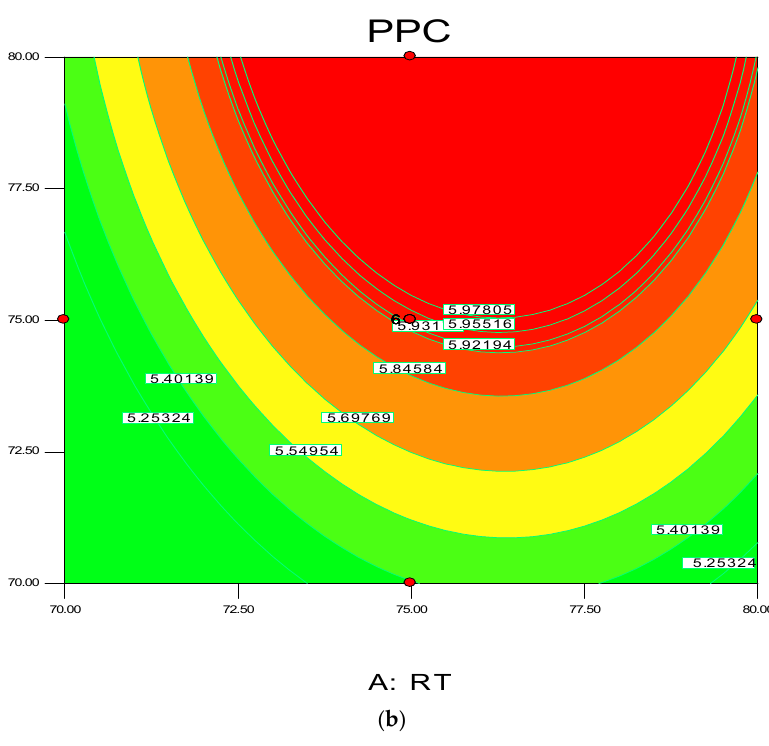
Figure 4. 3D response surface ( a ) with 2D contour plot ( b ) of reaction temperature (RT) and monomer concentration (MC).